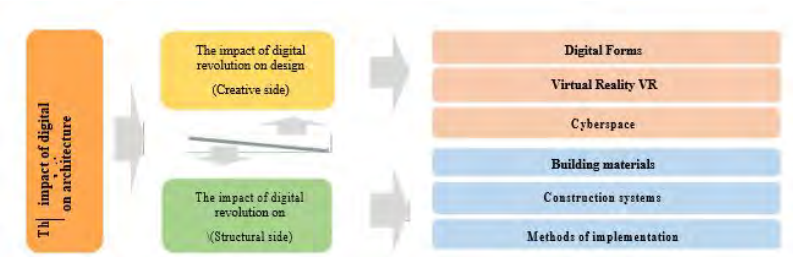
Figure 5. Theimpact of digital revolution on architecture.